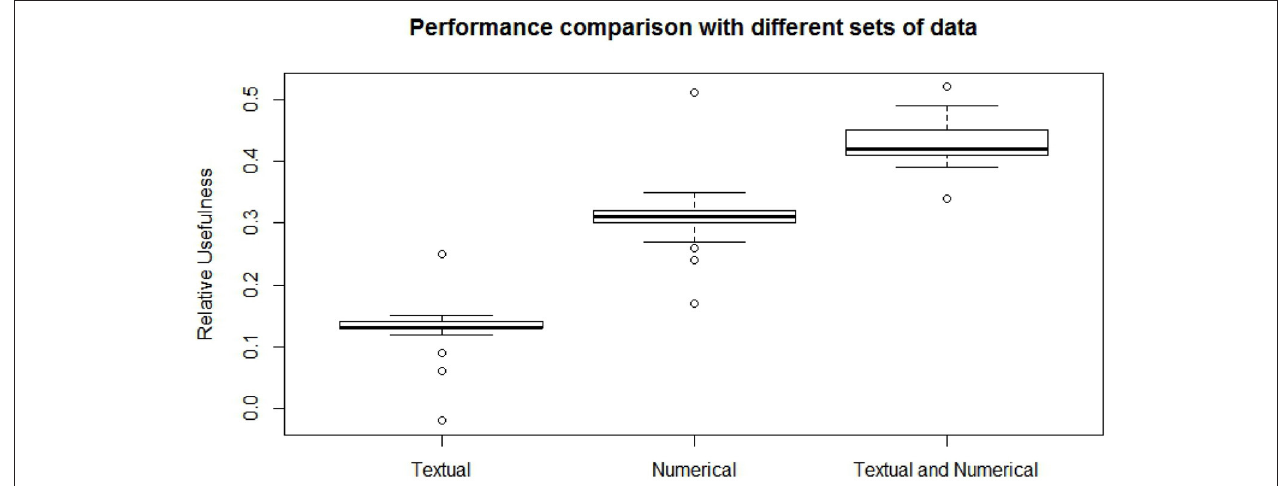
FIGURE 5 | Comparison of the relative usefulness obtained with the textual financial data (left) , numerical financial dataset (center) , and with their combination (right)